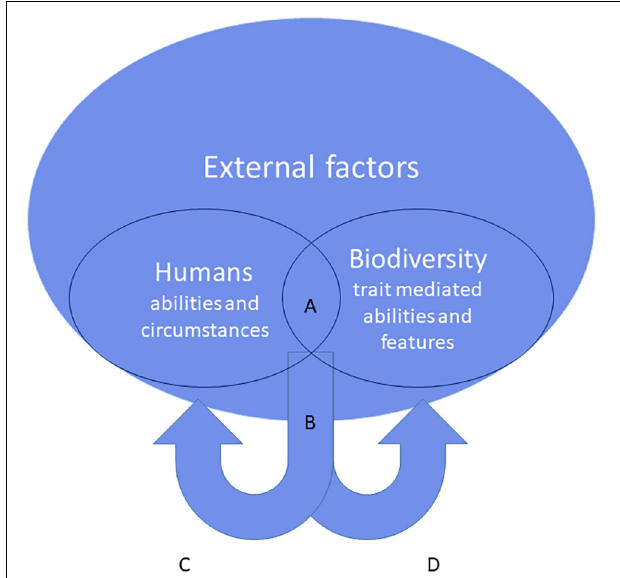
FIGURE 1 | The reciprocal interaction between people and biodiversity. Through their features and abilities (mediated by functional traits) organisms create opportunities for affordances (A) . These become real when they are complemented by human abilities and external factors. Realization of affordances (B) through an interaction between the organism and a person may ultimately confer direct and indirect benefits for human health and well-being (C) . The response of the organism to the same interaction is again mediated by functional traits (D) . The interaction and its outcomes may change the future availability of the initial set of